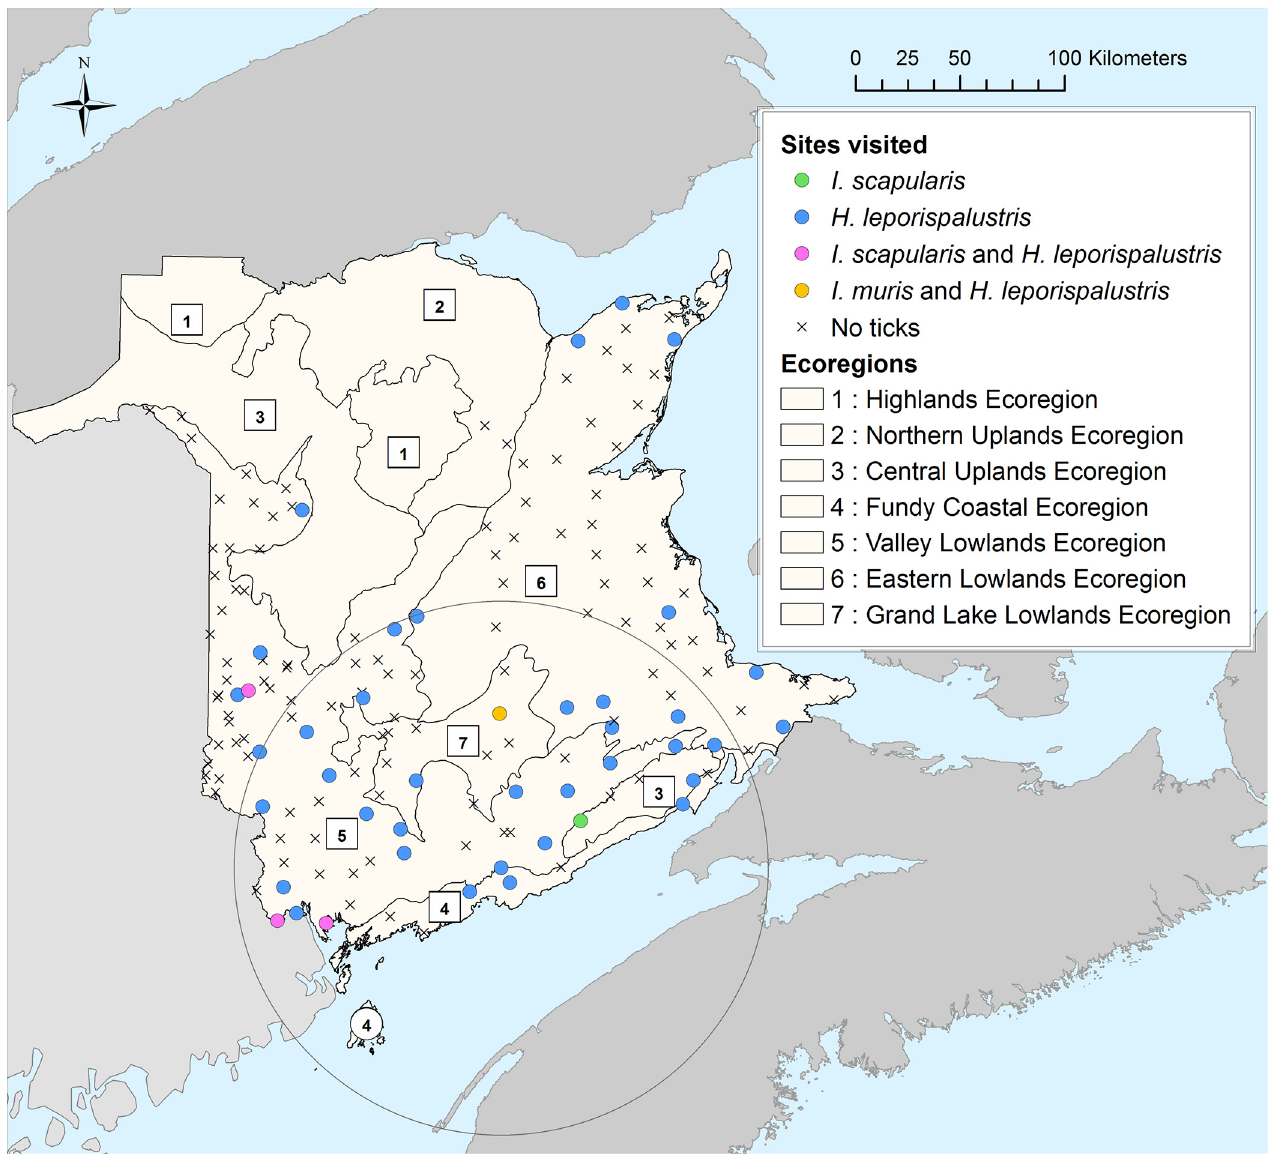
Fig 1. Distribution of sampling sites and tick-positive sites. Sites of occurrence of I . scapularis (green), H . leporispalustris (blue), I . scapularis and H . leporispalustris (pink) and I . muris and H . leporispalustris (yellow) are shown. The black circle indicates a significant cluster of sites where H . leporispalustris ticks were found. The two sites where I . scapularis were found in previous field studies are identified by red stars. The map was created in ArcGIS Version 10.2 (ESRI. Redlands,